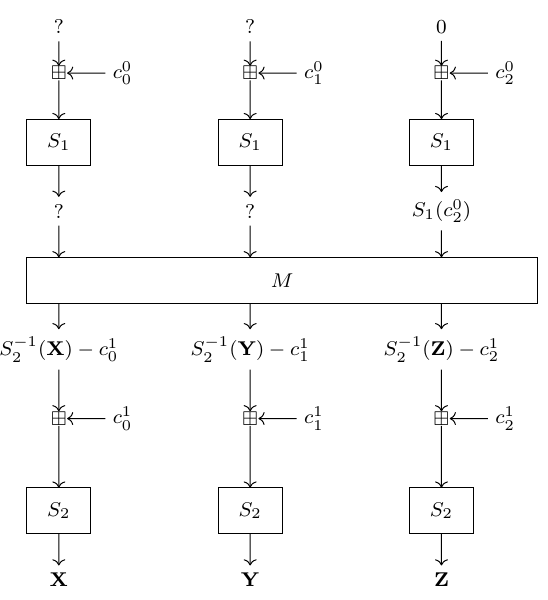
Figure 3: Bypassing Two SPN Steps ( 𝑡 =